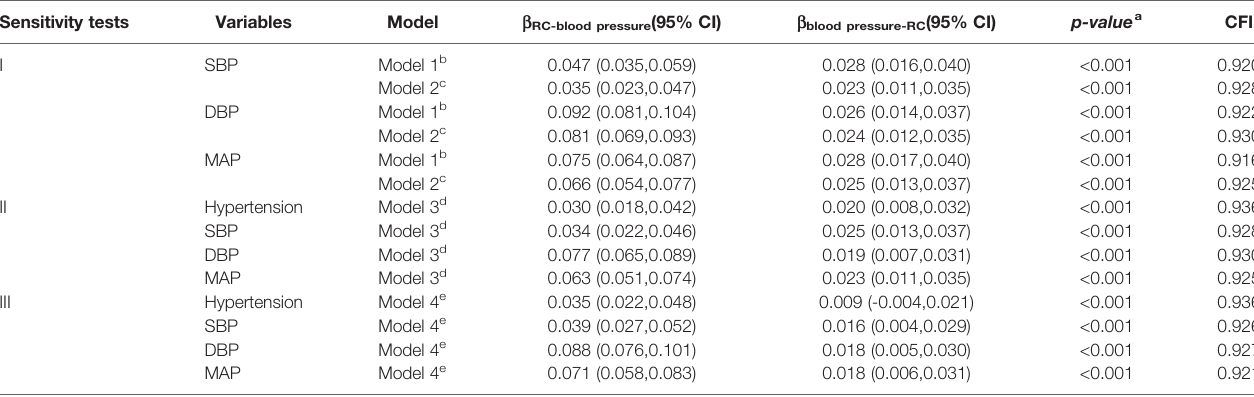
TABLE 6 | Cross-lagged standard regression coef fi cient of RC and blood pressure levels in the sensitivity analyses. Sensitivity